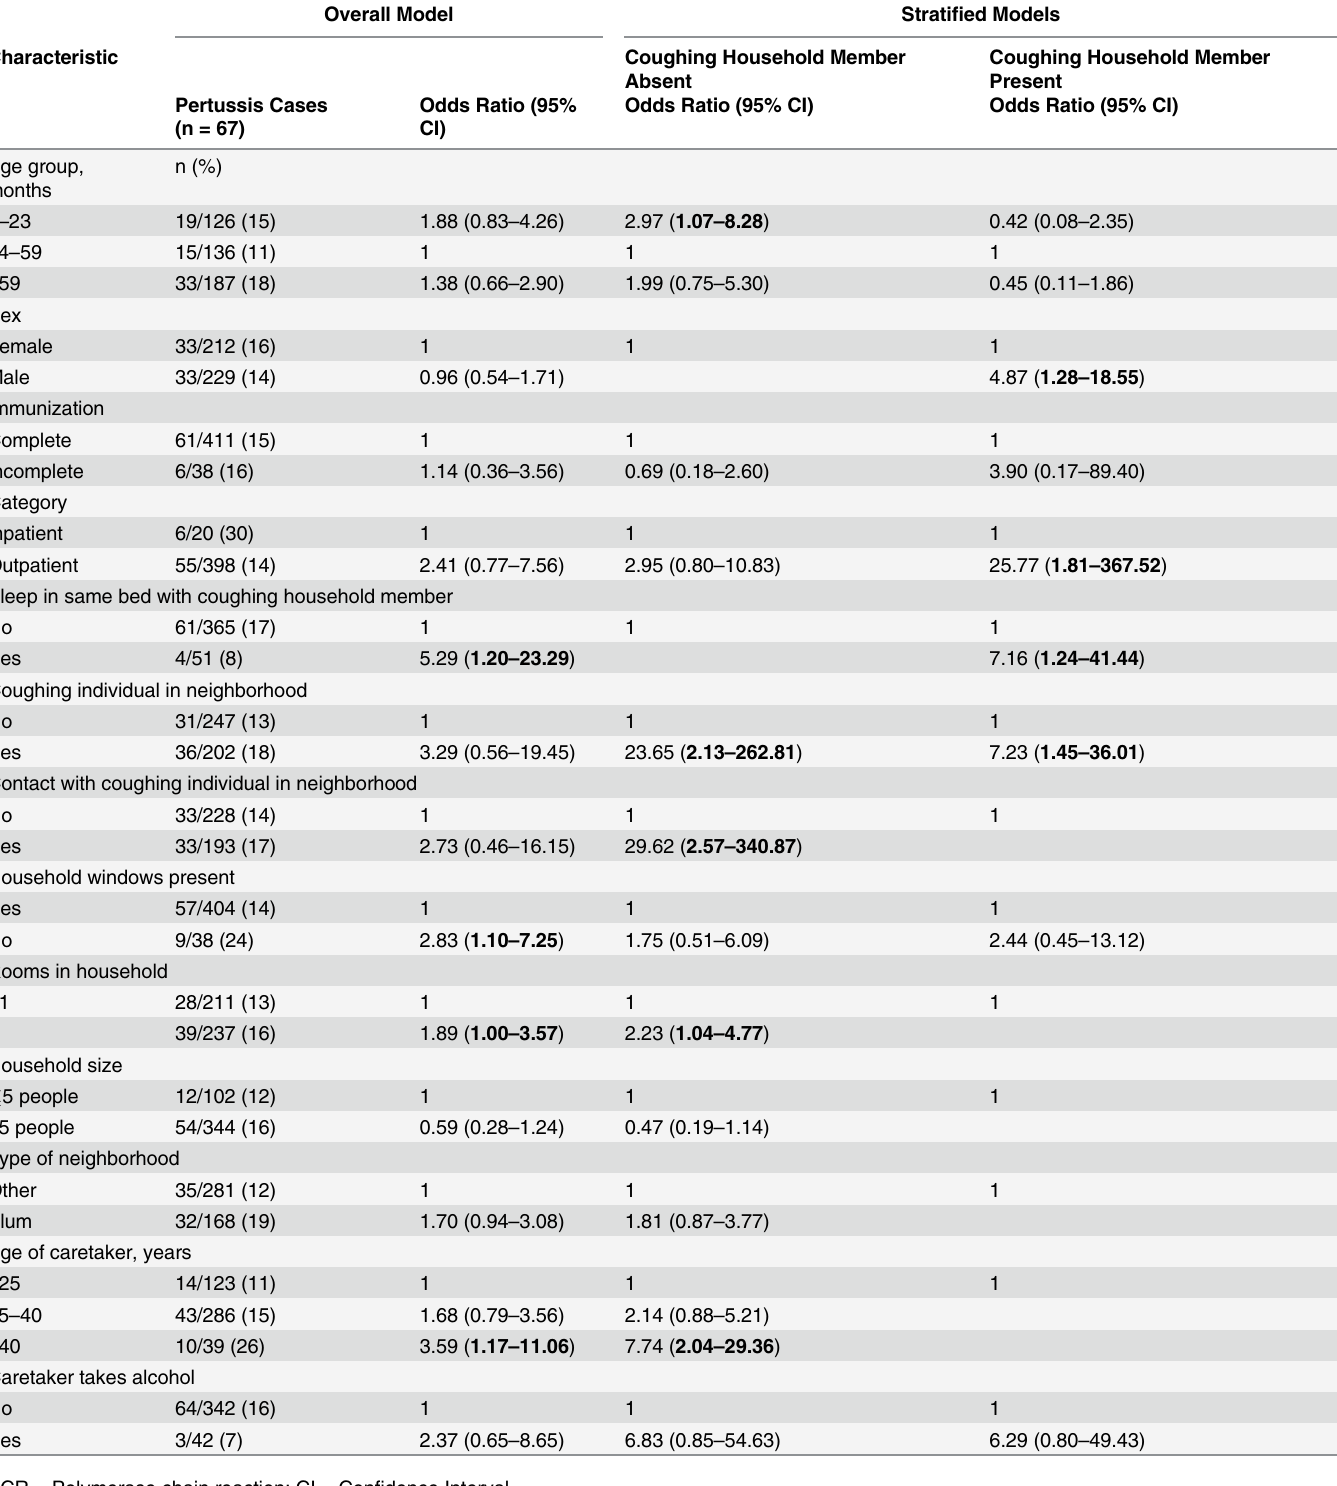
Table 2. Host and environmental factors associated with confirmed pertussis by PCR among 449 children at a national referral teaching hospital in Uganda stratified according to status of a coughing household member. Overall Model Strati fi ed